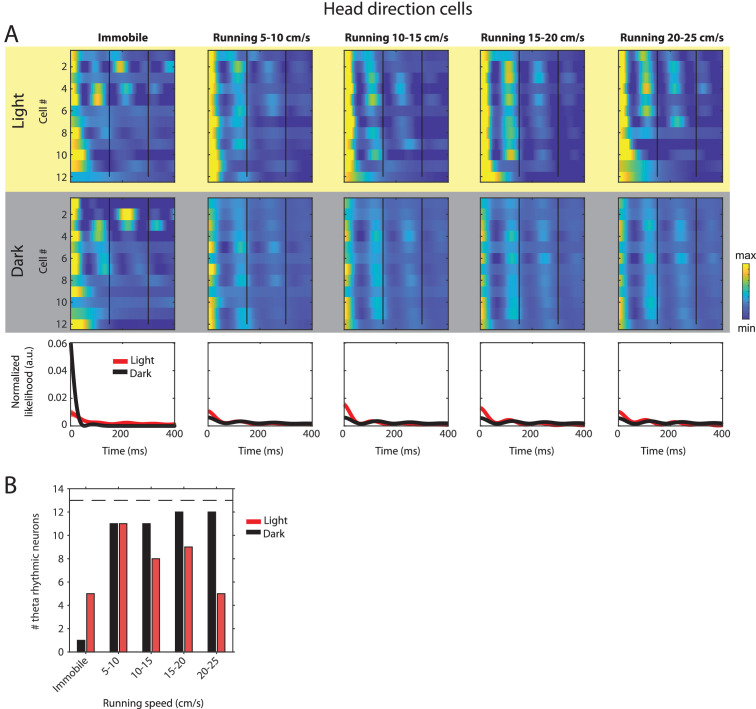
Changes in theta rhythmic firing as a function of running speed and visual inputs in theta rhythmic head direction cells.Red color or yellow background indicates data on the light condition, black and gray color or gray background indicates data on the dark condition. (A) Upper panels show the color coded MLE autocorrelogram models for each of n = 12 theta rhythmic head direction cells at different running speed intervals. Immobility was defined as running speed <3 cm/s. Neurons are sorted per condition in order of their theta rhythmic firing frequency. Bottom row shows the average across autocorrelogram models per condition. (B) Number of neurons shown in A with statistically significant spiking rhythmicity at alpha = 0.1 determined by the MLE model for different running speeds in light and dark. A longitudinal analysis of changes in frequency or magnitude of theta rhythmic firing as a function of running speed could not be performed because the number of neurons with significant theta rhythmic modulation across all running speed bins was smaller than three in light and dark conditions.